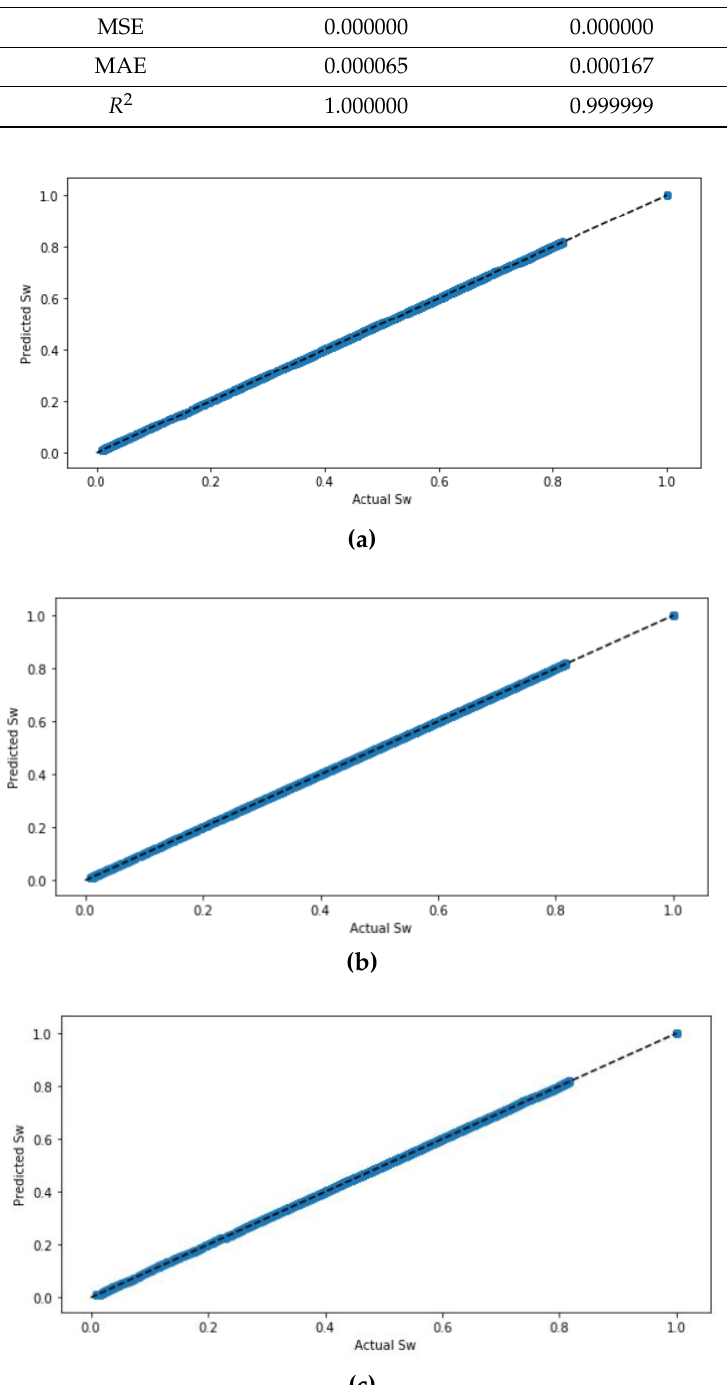
Figure 7. Scatter plots of ANN models with different activation functions (a) “ReLu” activation function, (b) “sigmoid” activation function, and (c) “tan h ” activation function, function, ( b ) “sigmoid” activation function, and ( c ) “tan h ” activation function, for target S w . The for target S w . The dashed line represents a full coinciding between actual and predicted dashed line represents a full coinciding between actual and predicted data.